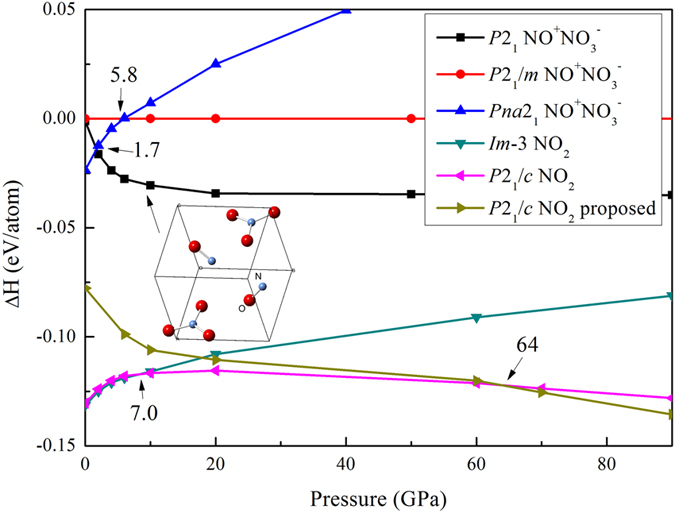
Enthalpies of NO2 phases as a function of pressures.